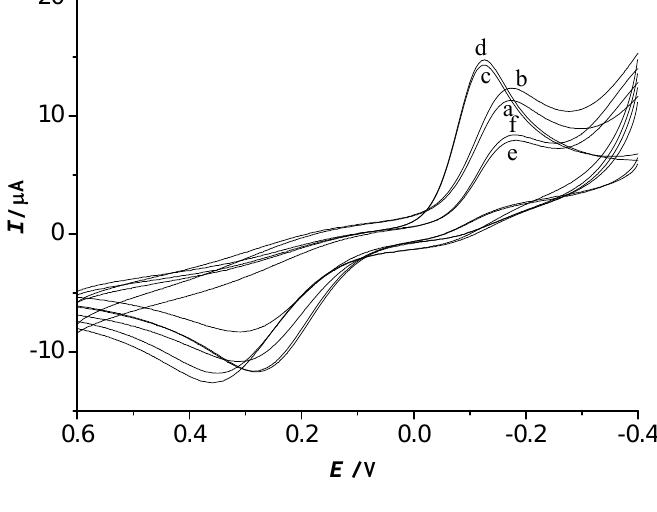
O /CS-Hb-GCE (e,f) in the absence (a,c,e) and in the presence (b,d,f) 3 4